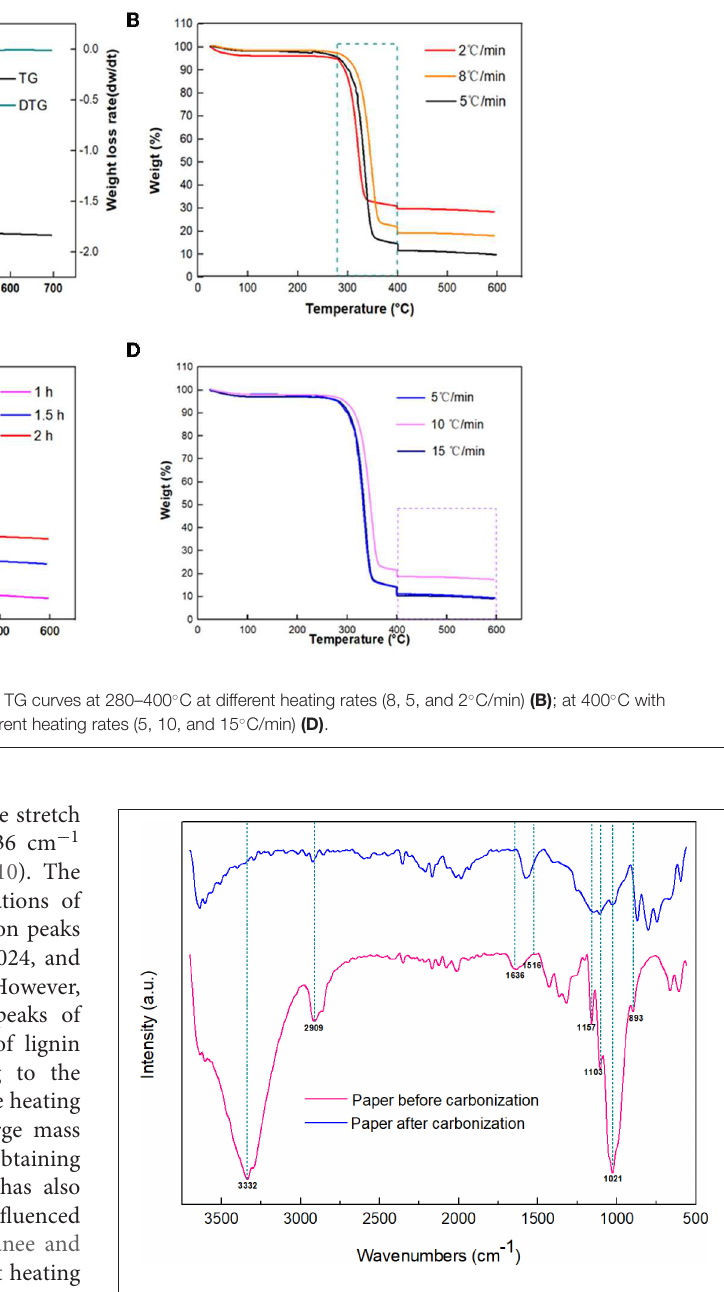
FIGURE 3 | FTIR spectra of sisal hemp pulp-based papers before and after